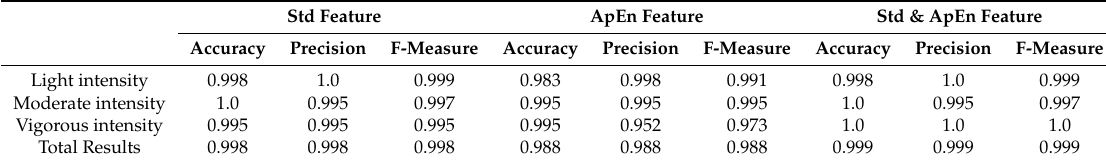
Table 8. Activity level recognition for using the pressure sensor cushion.